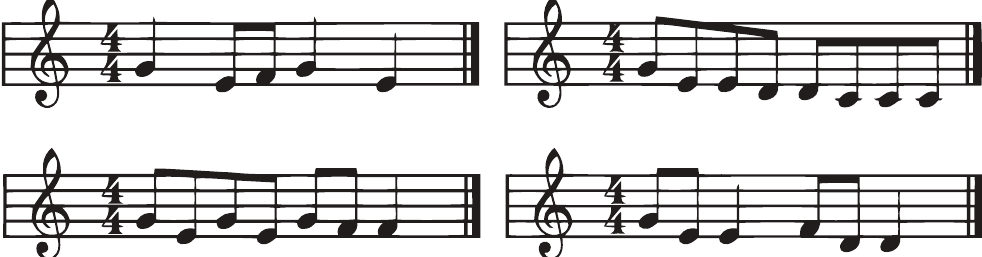
Figure 2: Overview of the stimuli (nursery rhymes) used in the melody recognition task. The stimuli were the nursery rhymes “H¨ansel und Gretel” (first row, left), “Der Kuckuck und der Esel” (second row, left), “Weil heute Dein Geburtstag ist” (first row, right), and “H¨anschen klein” (second row, right). These stimuli were known to all